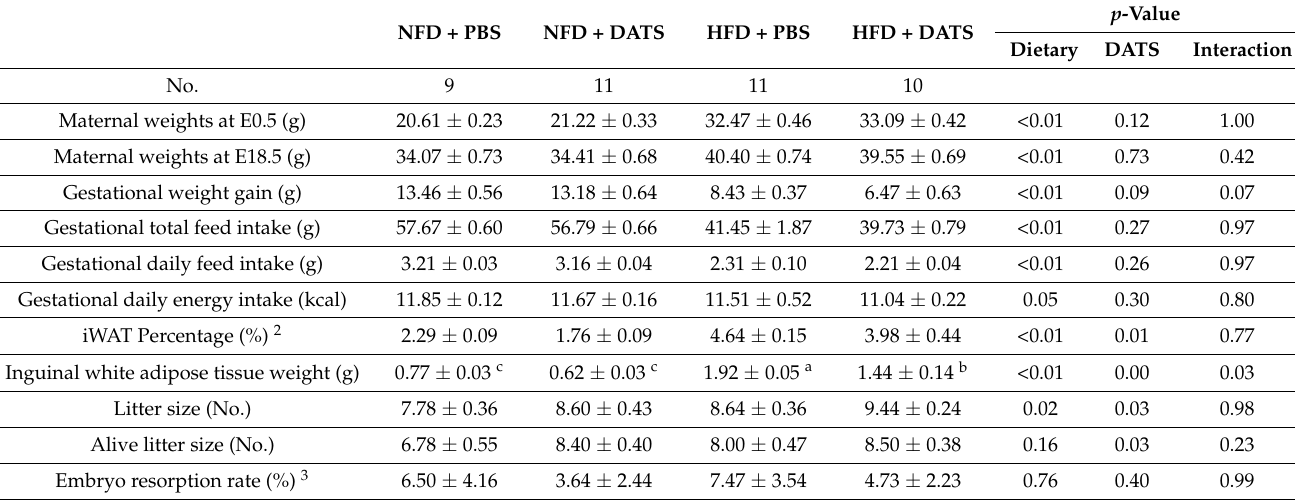
Table 1. Effects of DATS treatment on maternal characteristics and reproductive performance 1